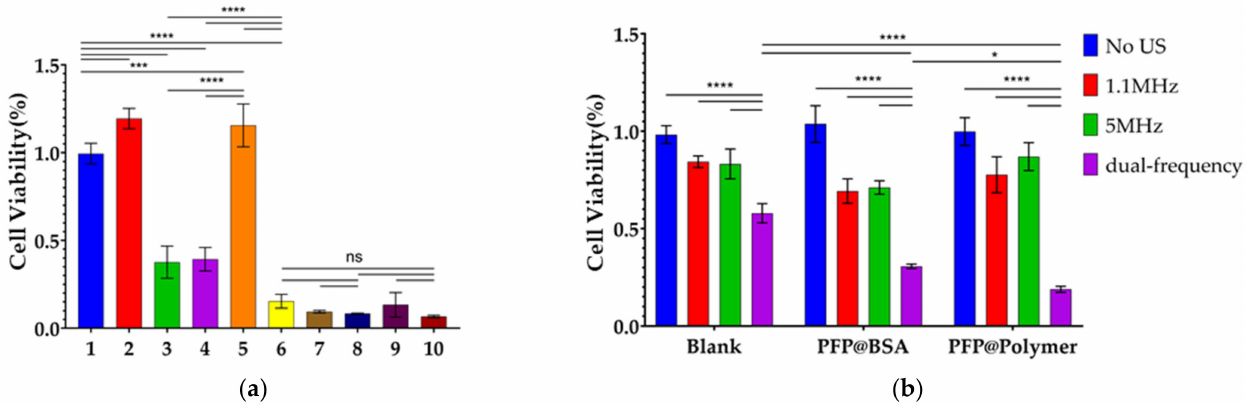
Figure 4. In vitro cell viability ( a ) after single-frequency and dual-frequency (both at 10 W) HIFU irradiation, with 1.1 MHz at various power values (10 W, 20 W, 30 W), by using cell-counting kit-8 (CCK-8) assay. The irradiation time of dual-frequency HIFU was 20 s; the power of 5 MHz HIFU was 10 W, and PFP@Polymer NPs were at the same volume concentration (0.002% v / v ). 4T1 cells were divided randomly into 10 groups: (1) control, (2) only NPs (0.002% v / v ), (3) 1.1 + 5 MHz US (10 + 10 W), (4) NPs + 1.1 MHz US (10 W), (5) NPs + 5 MHz US (10 W), (6) NPs + 1.1 MHz US + 5 MHz US (10 + 10 W), (7) 1.1 + 5 MHz US (20 + 10 W), (8) NPs + 1.1 MHz US + 5 MHz US (20 + 10 W), (9) 1.1 + 5 MHz US (30 + 10 W), (10) NPs + 1.1 MHz US + 5 MHz US (30 + 10 W). ( b ) Comparison of cell viability post 20 s irradiation of 1.1 MHz, 5 MHz, and dual-frequency HIFU in the following groups: blank (no addition of NDs or NPs), PFP@BSA (with the addition of the same